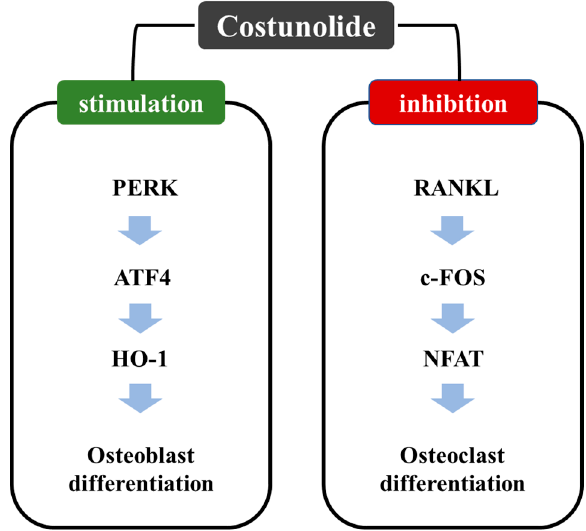
Figure 2. Effect of costunolide on differentiation of osteoblast and osteoclast. Costunolide induces osteoblast differentiation through ATF-4-induced HO-1 expression in mesenchymal stem cells. On the other hand, costunolide suppressed RANKL-mediated osteoclast differentiation via inhibiting RANKL-mediated c-Fos transcriptional activity in bone marrow cells.